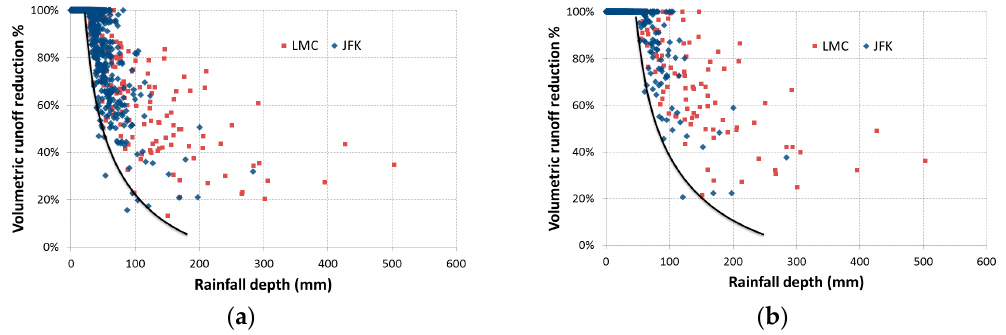
Figure 2. Relationships between percentage of volumetric runoff reduction and rainfall depth for Treatments A ( a ) and C ( b ).